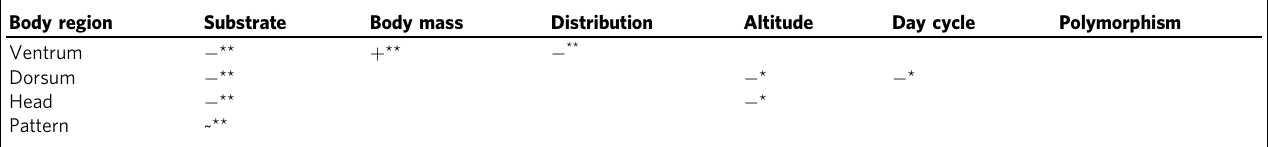
Table 2 In fl uence of variables on the integumentary brightness. Body region Substrate Body mass